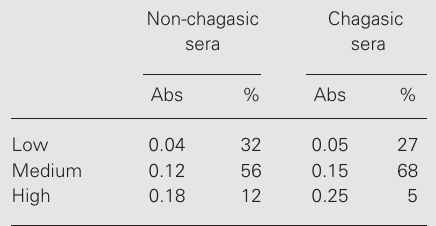
Thirty-six sera from chagasic patients and 22 sera from non-chagasic patients were tested by ELISA using HeLa UsnRNPs as antigen and their degree of reactivity (low, medium and high) was deter- mined. A chagasic serum with strong reactivity and normal human sera were used as positive and negative controls, respectively (data not shown). Mean absorbances (Abs) are given in